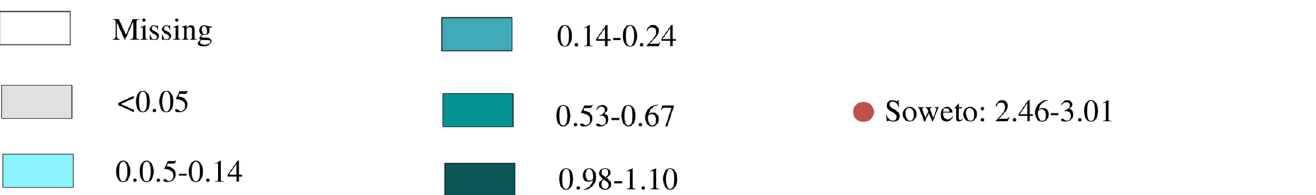
Fig 1. Chloropleth map of South Africa demarcating provinces (and Soweto) and their respective rates of infant GBS disease, 2004 – 2008.